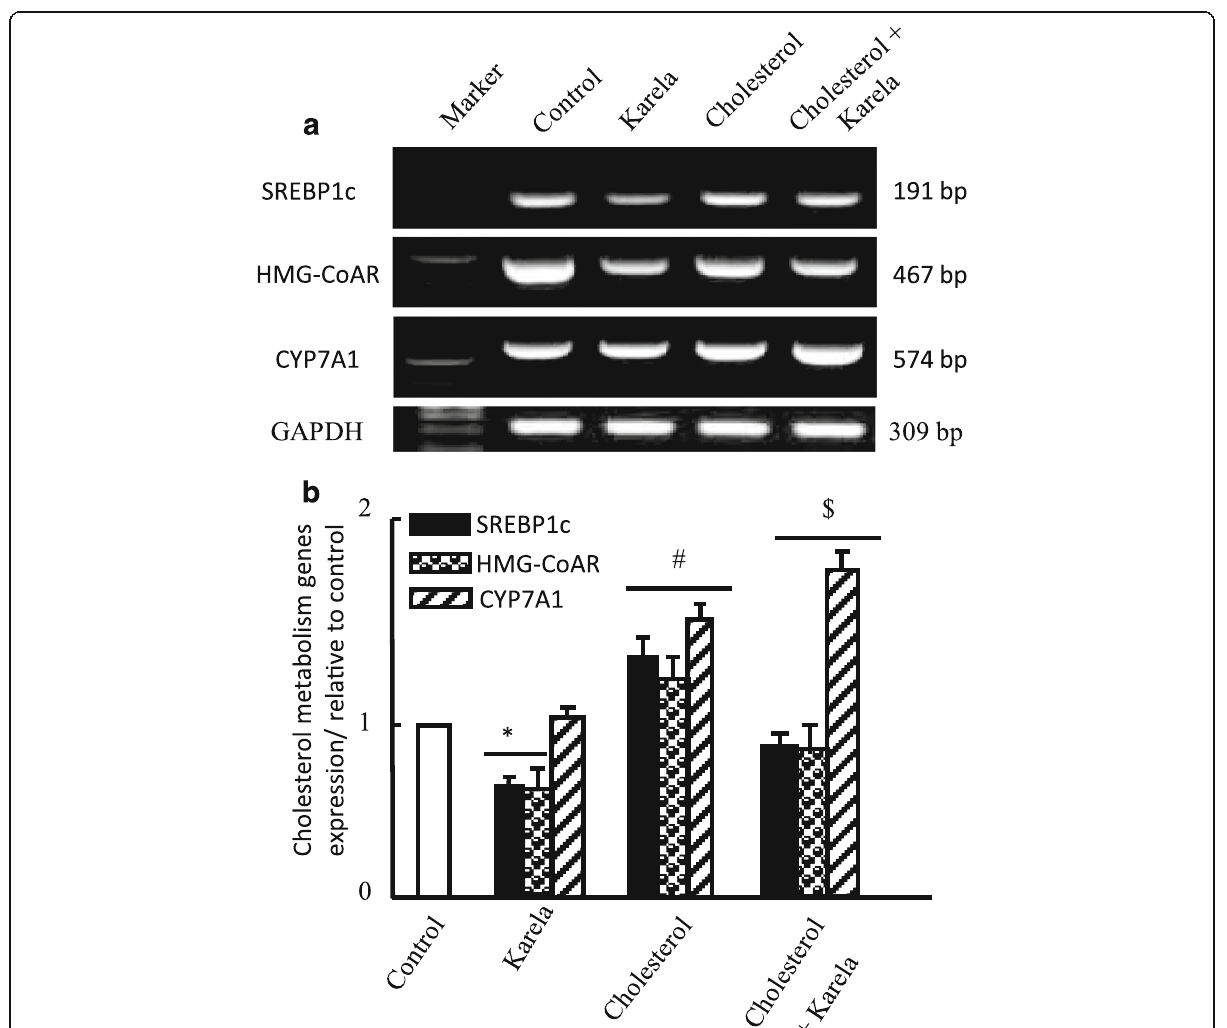
Fig. 7 Protective effect of karela on changes in SREBP1c, HMG-CoAR and CYP7A1 expression induced by hypercholesterolemia in liver. Hypercholesterolemic rats were administered karela for 4 consecutive weeks. Total RNA was extracted from liver tissues and the expressions of SREBP1c, HMG-CoAR and CYP7A1 were analyzed by semi-quantitative RT-PCR analysis. Values are means ± SE of 10 rats. * P < 0.05 Vs control group; # P < 0.05 VS karela group and $ P < 0.05 Vs hypercholesterolemic group. Upper panels ( a ) are mRNA expression of examined genes. Lower columns ( b ) are densitometric analysis of gene expression for upper